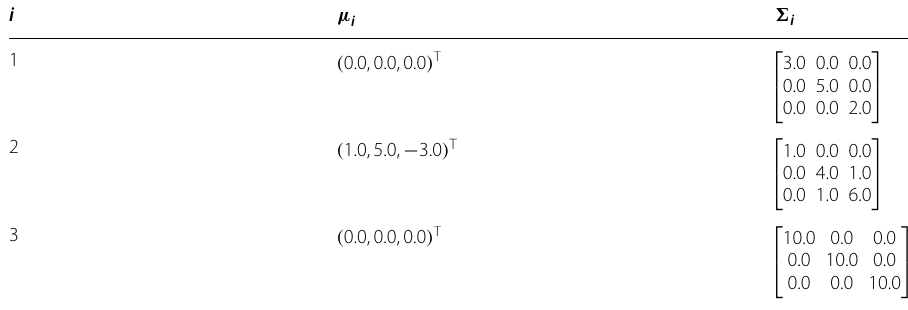
Table 2 The mean vectors and covariance matrices of three Gaussian distributions in Gaussian2